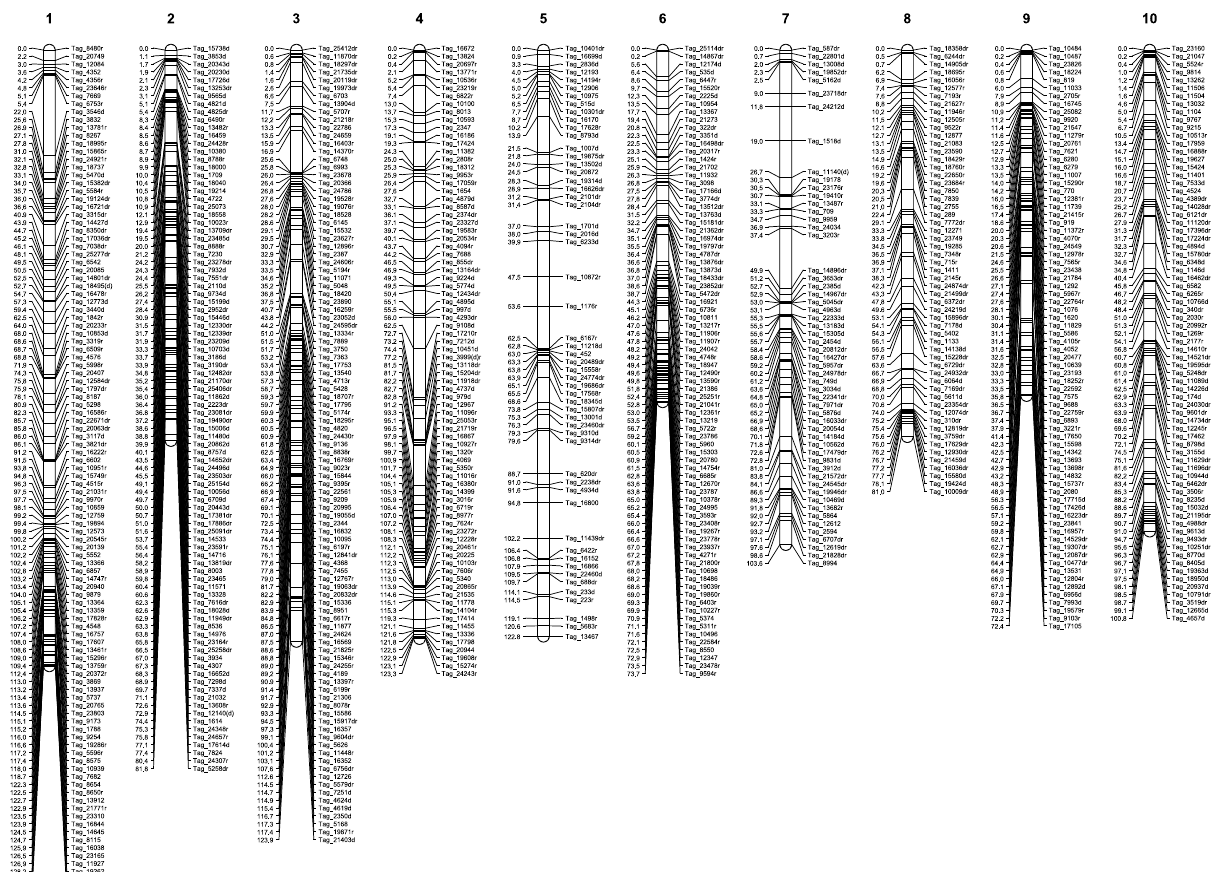
Figure 3. HH genetic map comprised of markers that were heterozygous in both 509022 and HI33. SNP markers were identified using a fragmented seashore paspalum genome sequence as reference. Only one marker per set of cosegregating markers is